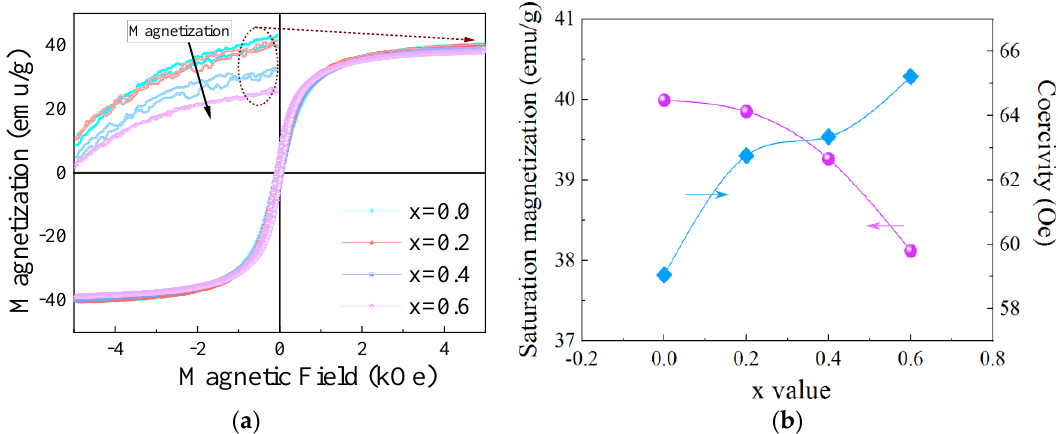
Figure 3. Magnetic hysteresis loops. ( a ) Magnetic properties and ( b ) samples sintered with various Sr 2+ ion substitution.